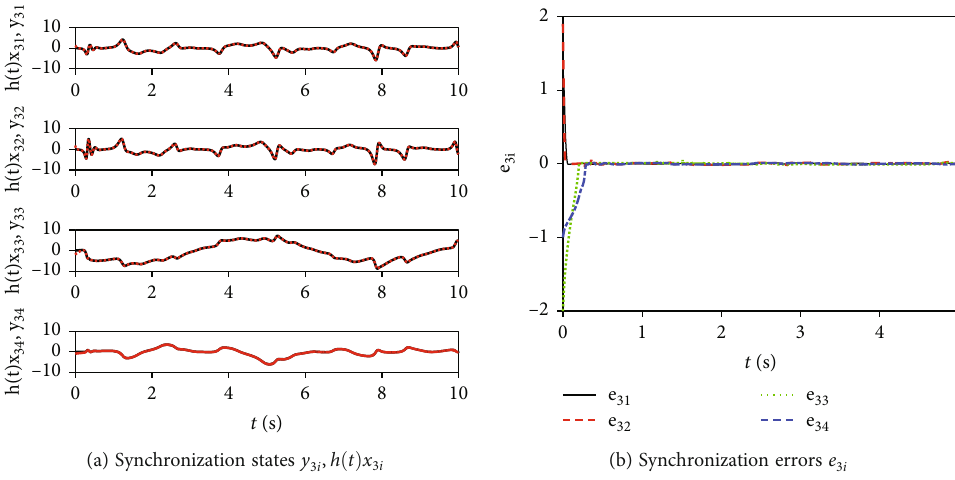
Figure 10: The time evolution of synchronization between y